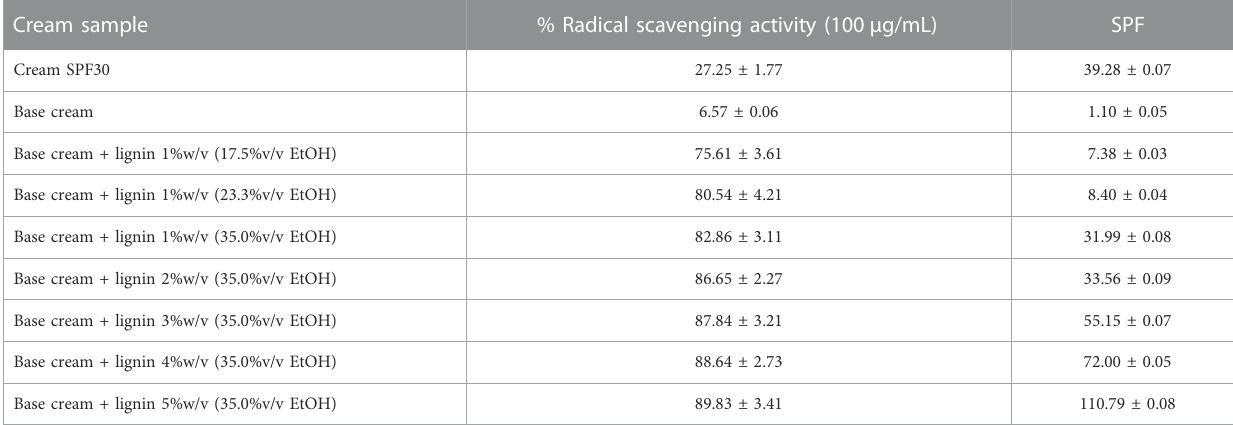
TABLE 3 Antioxidation property and SPF of cream SPF30 (commercial) and cream containing 1 – 5%w/v of thermal modi fi ed organosolv lignin (190 ° C) which precipitated at various solvent